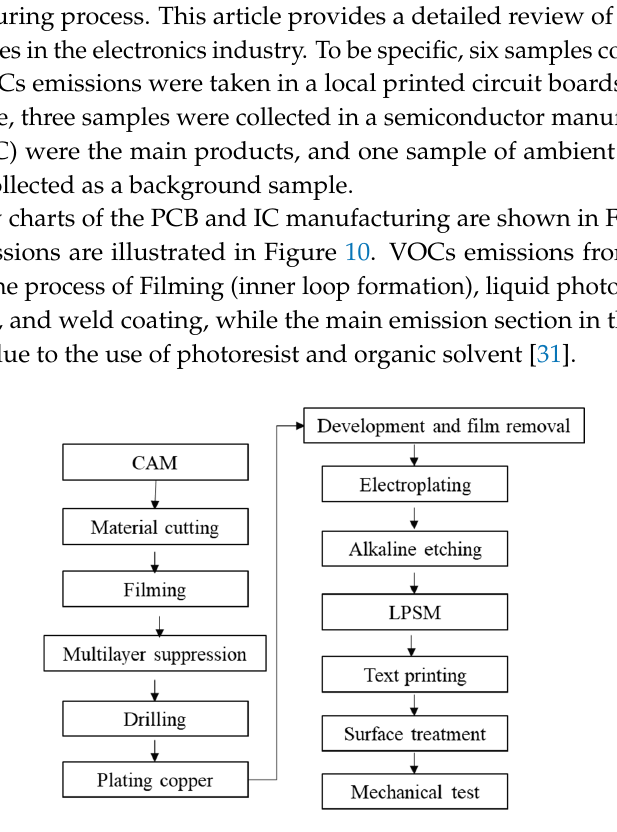
Figure 7. Comparison of major aromatics from auto coating in different regions.